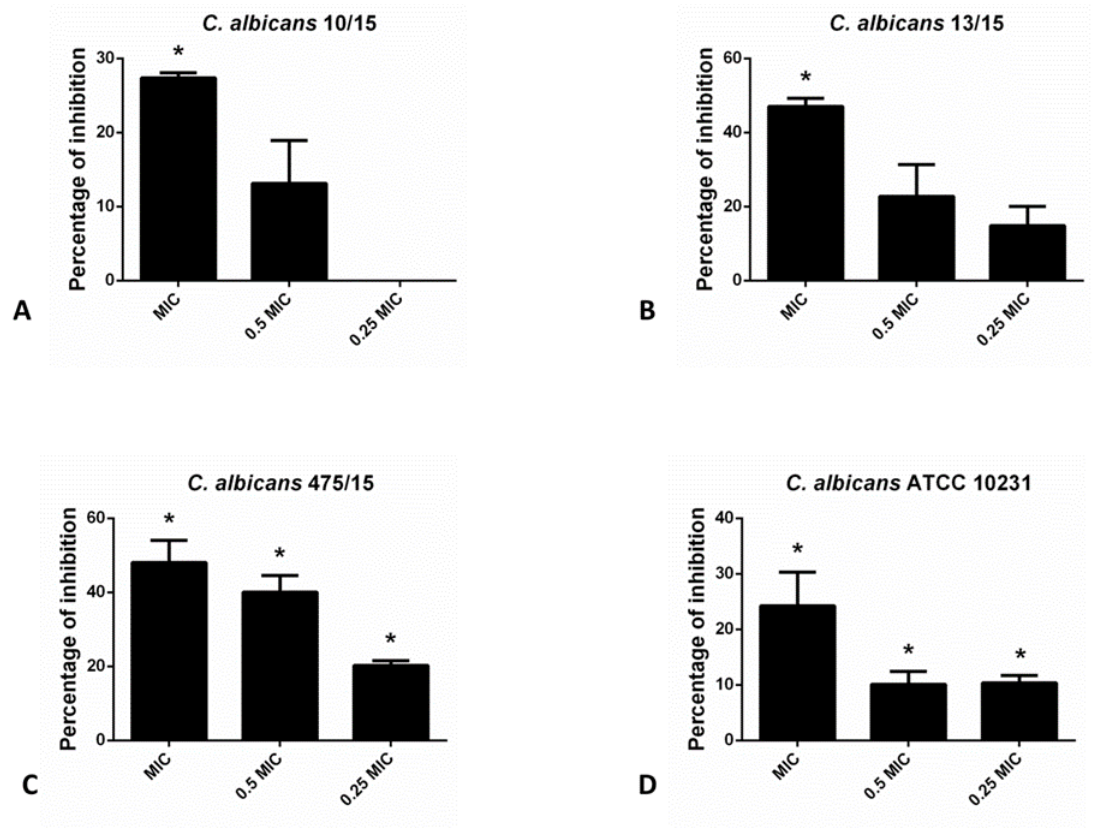
Figure 1. Inhibition of biofilm formation in different C. albicans strains: ( A )- C. albicans 10/15; ( B )- C. albicans 13/15; ( C )- C. albicans 475/15 and ( D )- C. albicans ATCC 10231 after application of hesperetin in concentrations 0.25 MIC (0.041 mg/mL), 0.5 MIC (0.082 mg/mL) and MIC (0.165 mg/mL). Mean values of triplicate independent experiments ± SD are shown. * p < 0.05 compared to